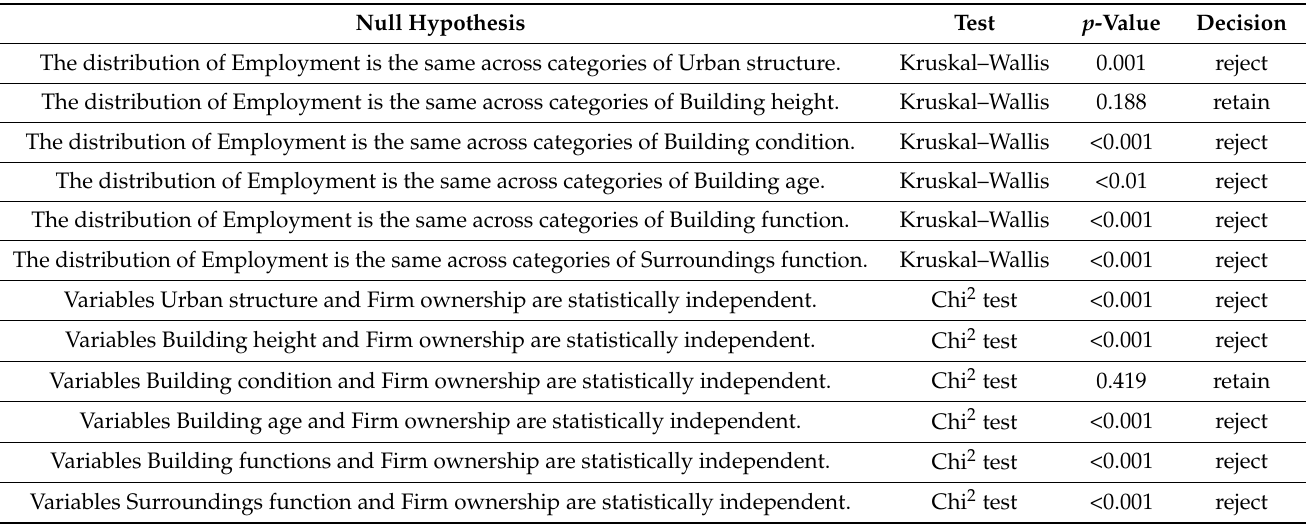
Table 4. Urban form and ICT firm size and ownership: statistical tests.